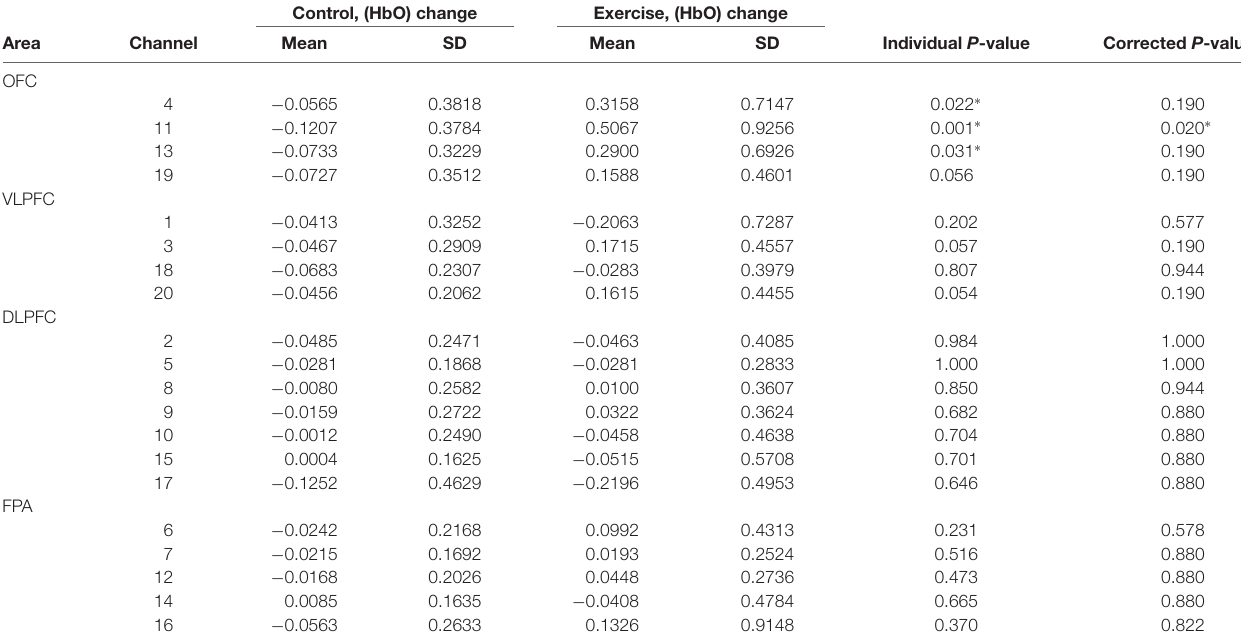
TABLE 3 | Mean changes in oxyhemoglobin concentration (HbO) among individuals viewing high-calorie food following moderate-intensity exercise or resting control sessions measured in 20 prefrontal NIRS channels divided into four areas. Control, (HbO) change Exercise, (HbO)